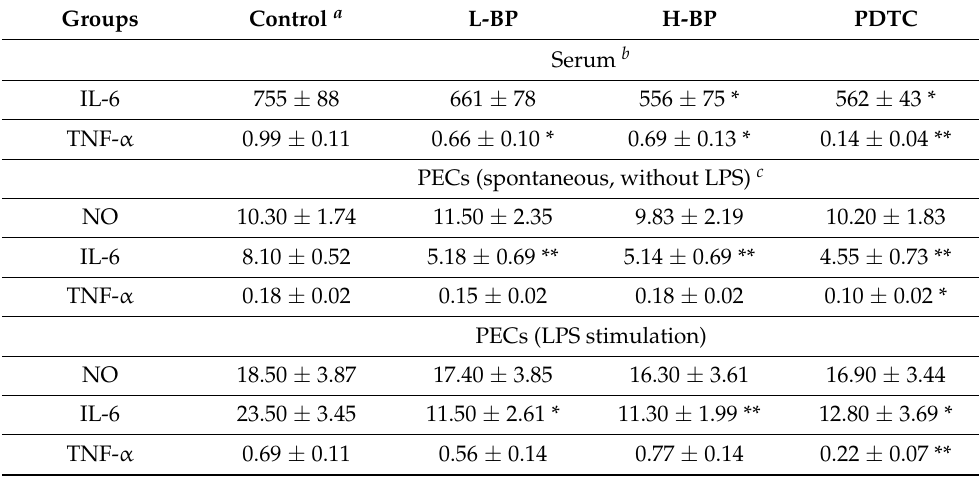
Table 1. The effects of BP-95E-H 2 O-BuOH extract administration on the release of pro-inflammatory mediators in serum and PECs from LPS-challenged